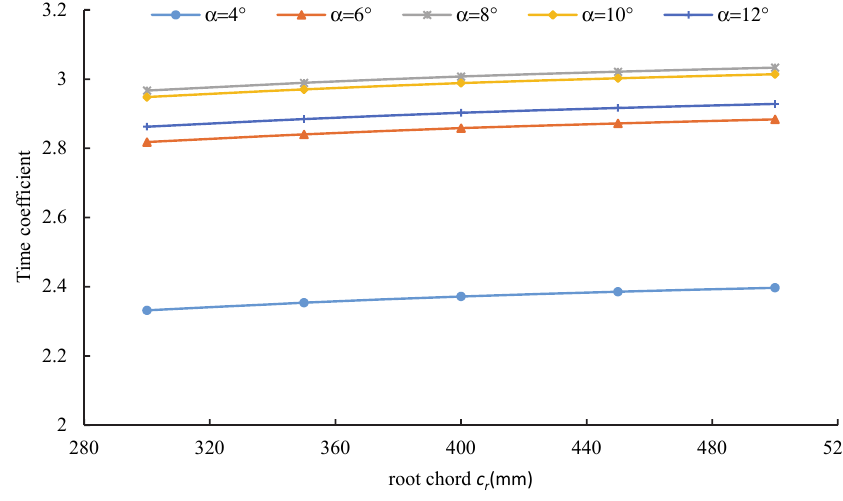
Figure 11. Relationship between the wing root chord length and time coefficient.